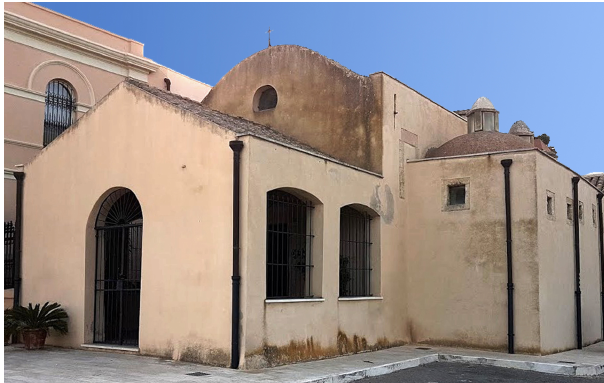
Figure 1. View of the old historic church of Saints Lorenzo and Pancratio in the old city centre of Cagliari.